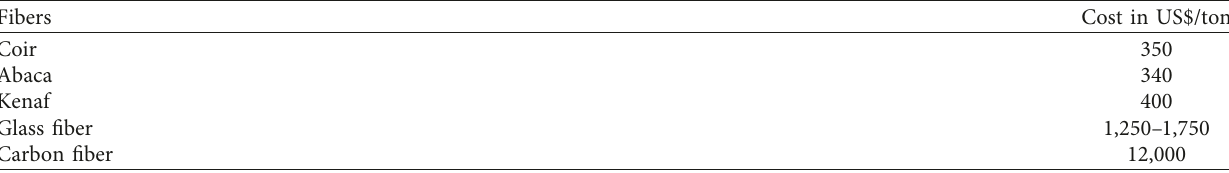
Table 8: Comparison of price between natural and synthetic fibers [8].